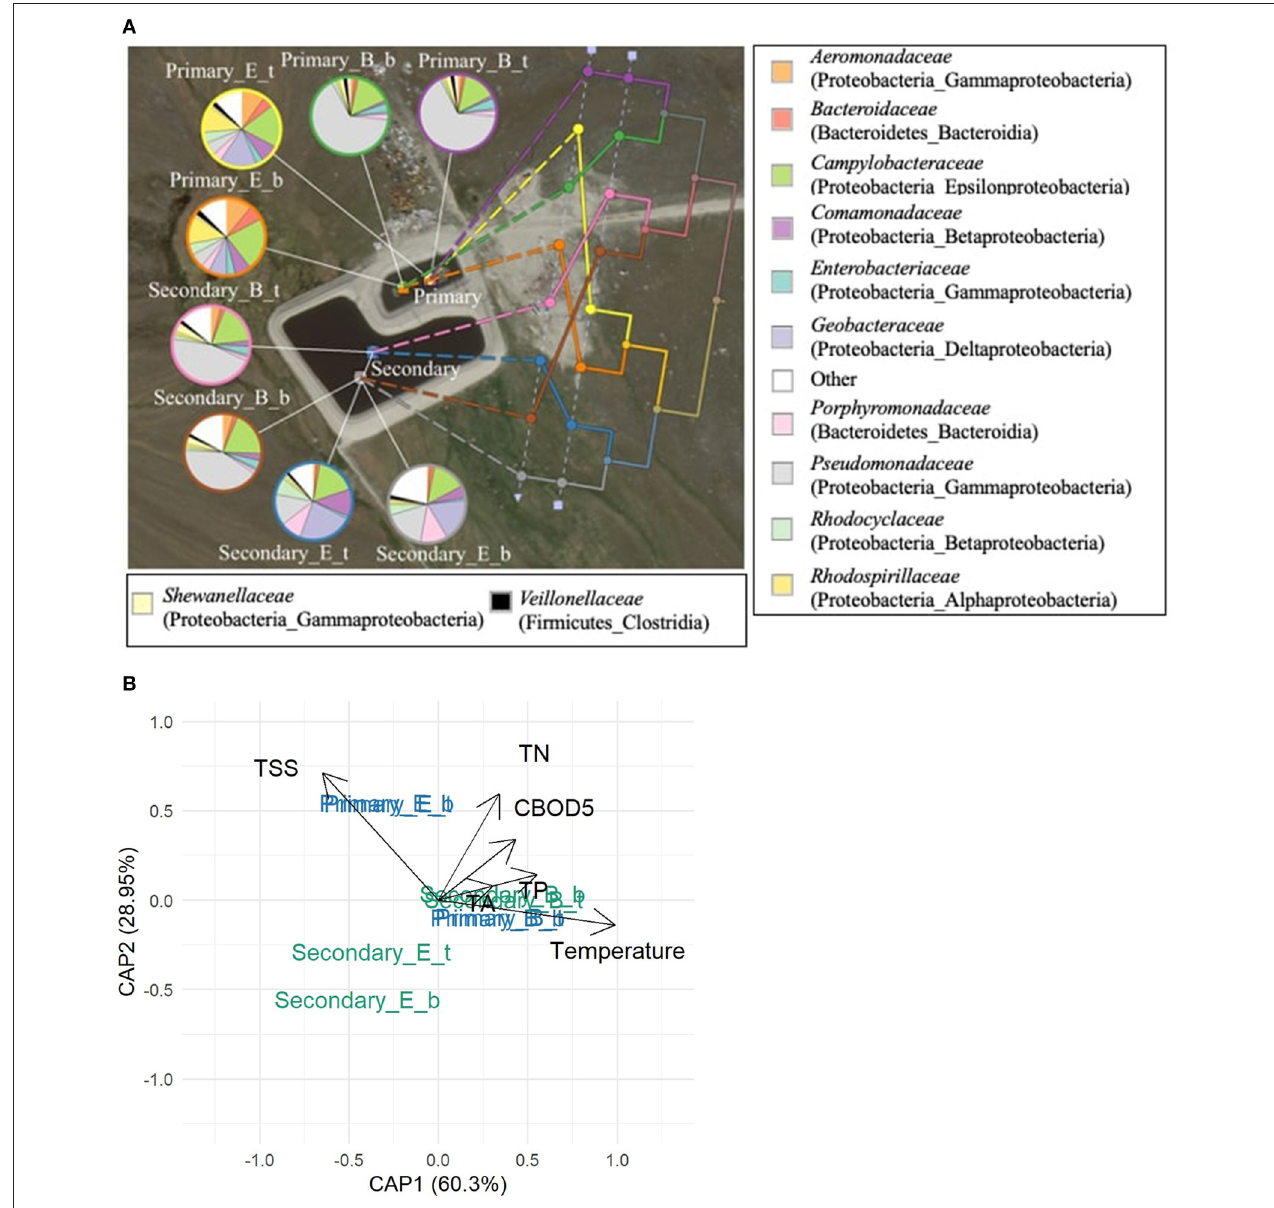
FIGURE 6 | Bacterial communities in Clyde River WSP system during the 2014 treatment season. (A) The UPGMA tree shows the phylogenetic beta-diversity of bacterial communities measured by the weighted UniFrac metric. The 12 most abundant bacterial families (relative abundances ≥ 10%, total of 269 bacterial families) are presented in the pie charts. Legends beside the pie charts: Primary – Primary pond, Secondary – Secondary pond; B – Beginning, E – End of summer treatment season; t – top and b – bottom indicates the sampling sites in the WSP, respectively. The legend beside the map shows bacterial families: the phylum and class names are listed in the bracket of each family name. Other: sum of bacterial families with relative abundances < 10%. (B) Distance-based RDA plot showing the relationship between temperature, water quality measures (TSS, TN, CBOD 5 , TA, TP, all significant, p < 0.05) and the seasonal phylogenetic bacterial beta-diversity in the pond